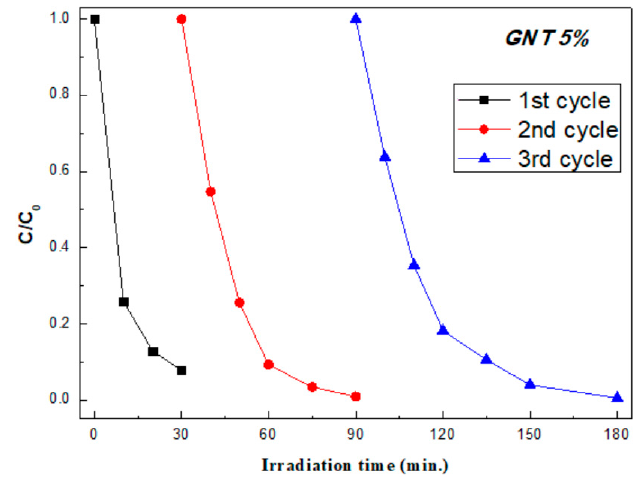
Figure 11. of GNT 5% fibers for three catalytic cycles.